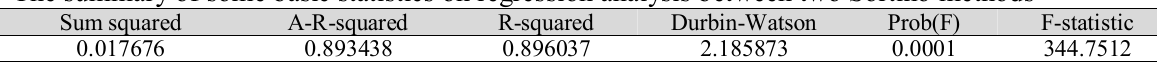
F-statistic Prob(F) Durbin-Watson R-squared A-R-squared Sum squared